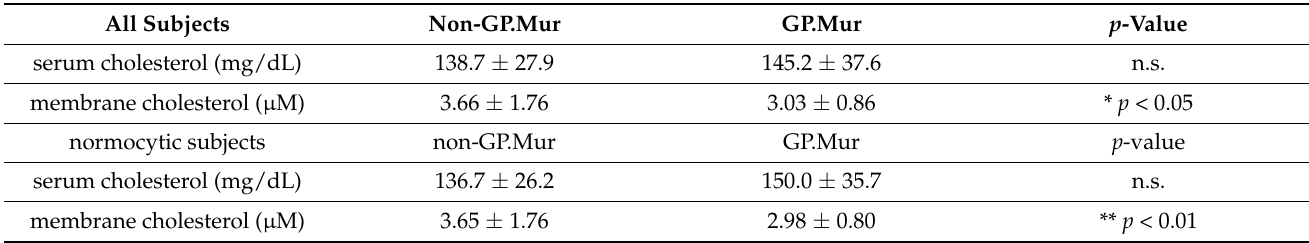
Table 5. The levels of serum cholesterol and membrane cholesterol in GP.Mur-positive and GP.Mur-negative adult subjects. ** p < 0.01; * p < 0.05; n.s ., not significant.